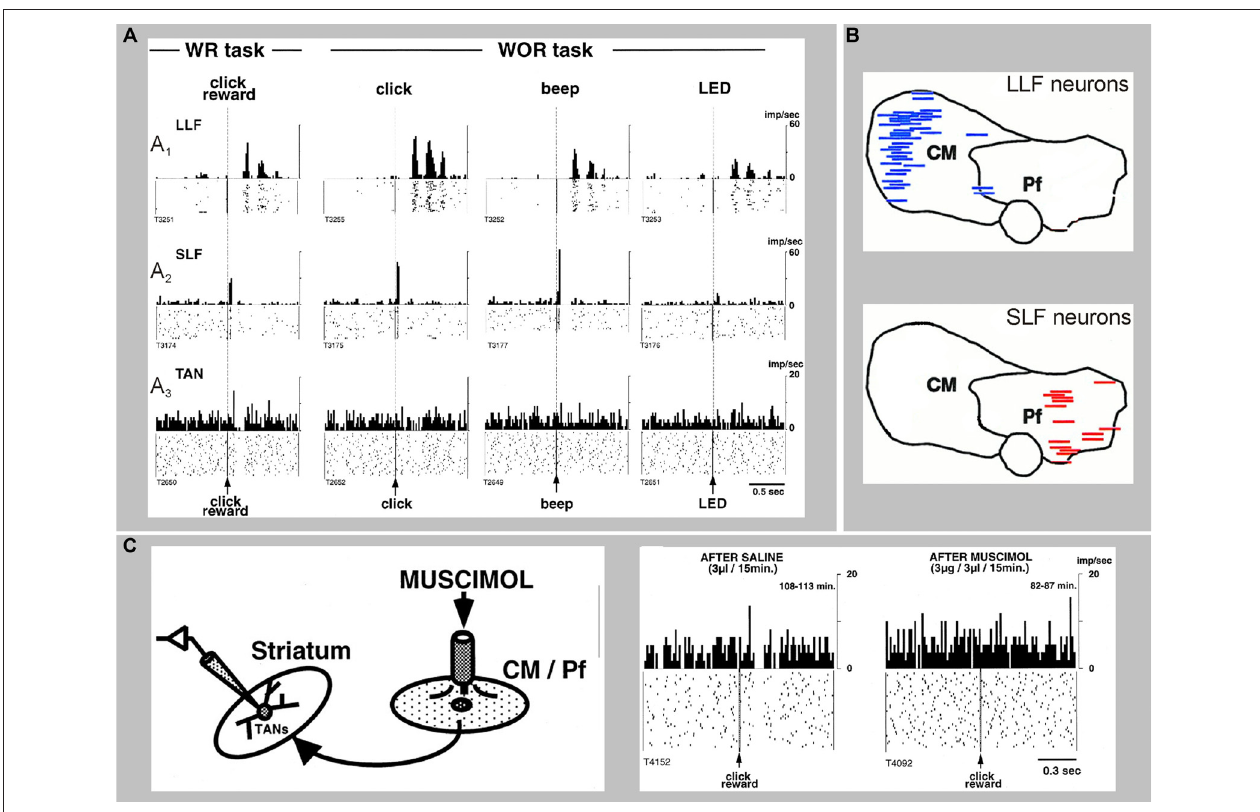
WR task. (B) Localization of LLF and SLF neurons in the monkey CM/Pf complex. Note the complete segregation of these two populations of neurons in CM or Pf. (C) Application of the GABA A receptor agonist muscimol in CM/Pf alters the pattern of responses of striatal TANs to the presentation of reward-related sensory stimuli in awake monkeys, The rasters and histograms on the right demonstrate that the pauses in the TAN responses are abolished after application of muscimol in CM/Pf (reproduced with permission from Matsumoto et al.,